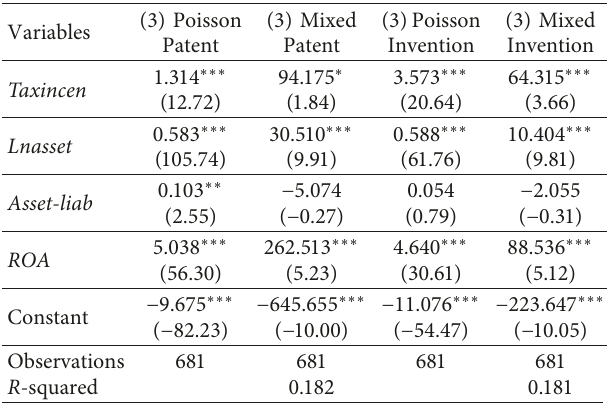
Table 4: Tax incentive policies-innovation output model.